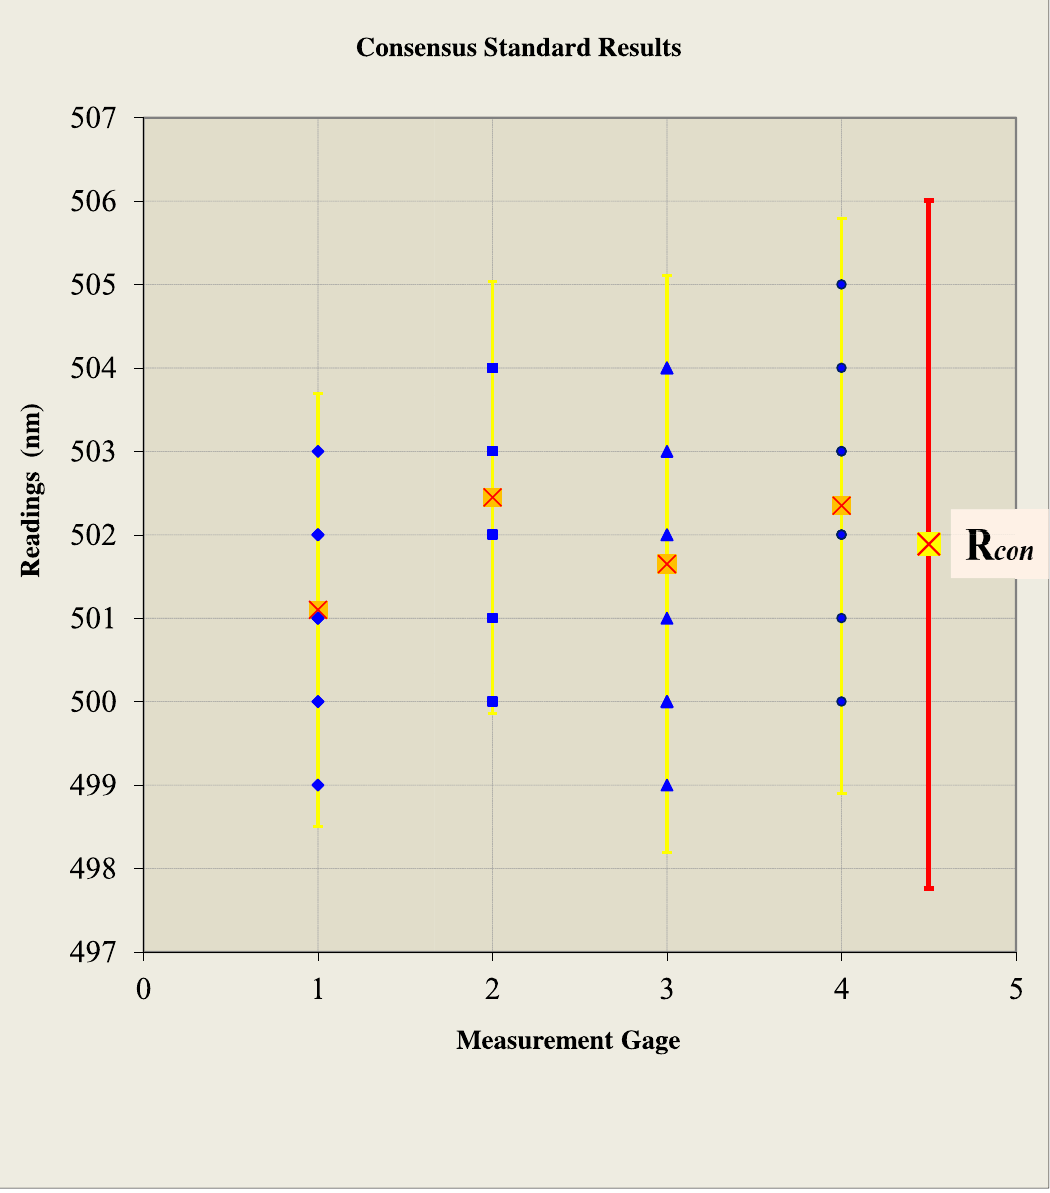
Fig. 3. Example 2. Results of consensus standard work: R con ≅ (502 ± 4) nm (red bar.) Yellow bars represent the ± expanded measurement uncertainty per Eq. (22). [See Example